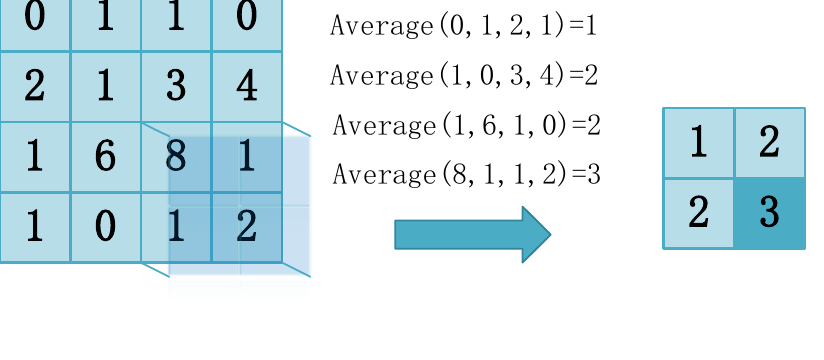
Figure 4. Average Pooling